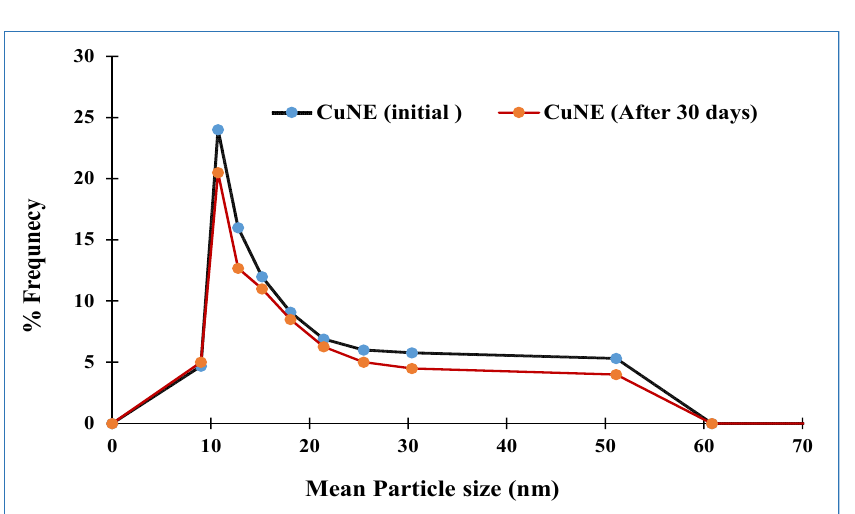
Figure 1. Stability data of curcumin nanoemulsion sample in term of PSD. Figure 2a,b show the optical microscope image of CUNE with concentrations of 0.15